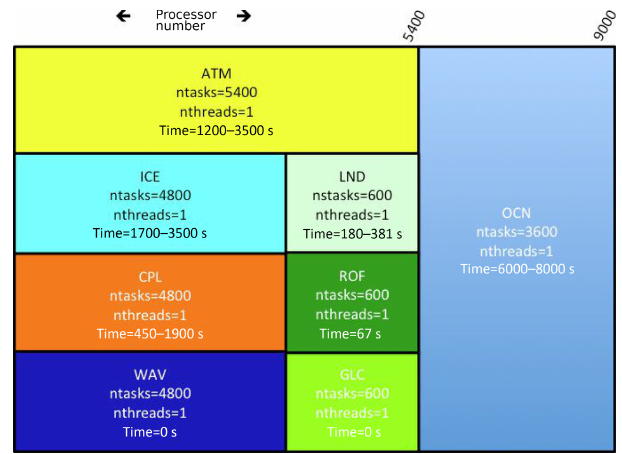
Figure 4. Example E3SM process execution layout for a problem